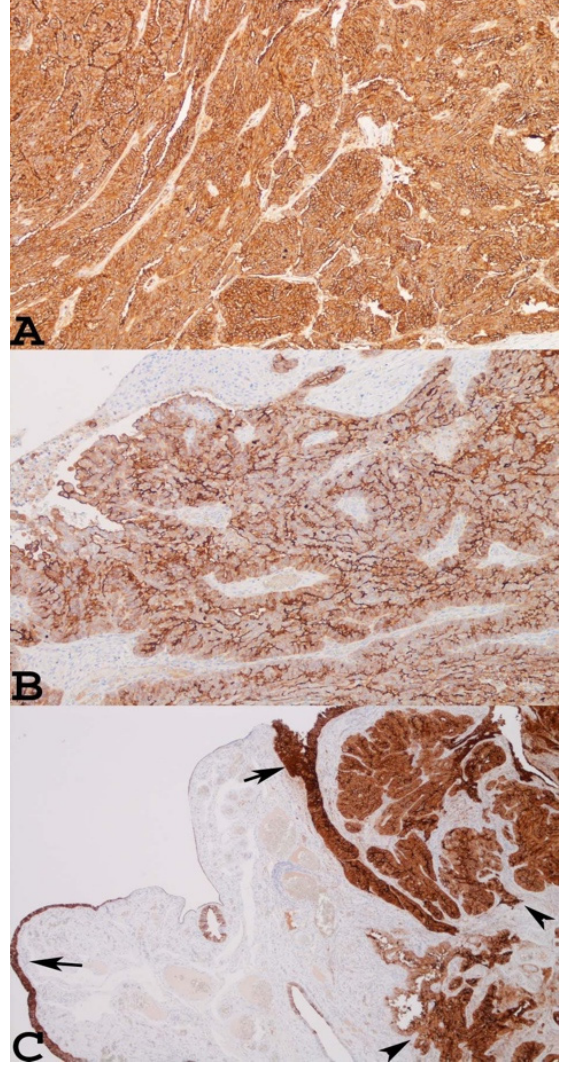
Figure 1. Two individual examples of advanced serous ovarian carcinoma showing diffuse mesothelin immunoreactivity: ( A ) score 4+, ×100; ( B ) score 3+, ×100. A personal example of STIC with a small nest of invasive serous carcinoma in a woman with BRCA-1 mutation and a previous history of breast cancer, showing strong immunoreactivity for MSLN in both lesions ( C ). Arrows indicate STIC, arrowheads indicate invasive serous carcinoma ×40.